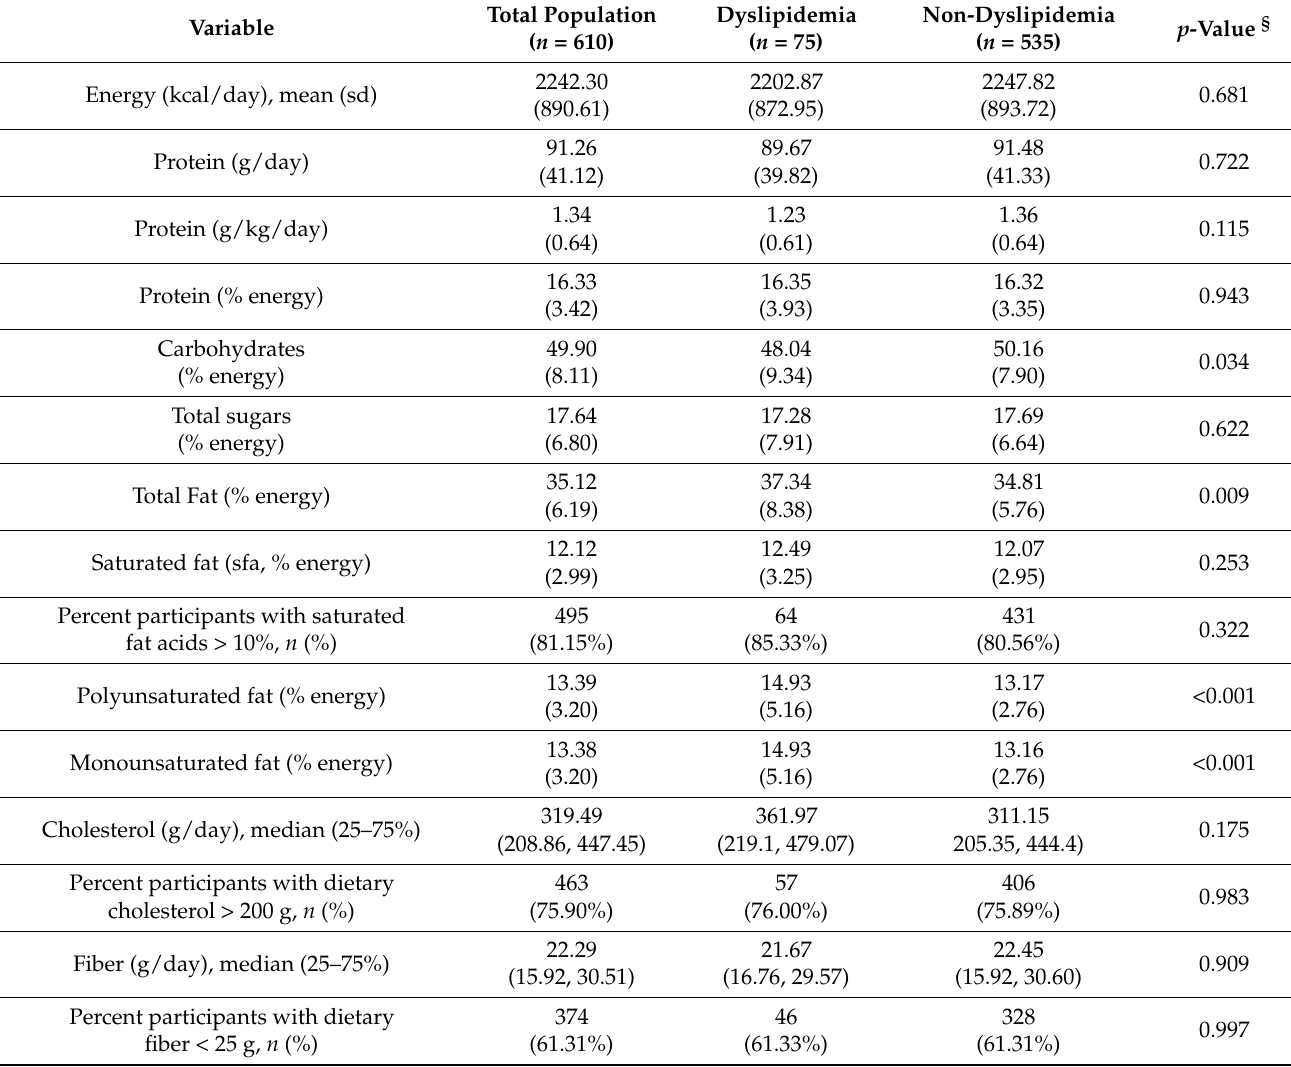
Table 3. Macronutrient intakes of adults with and without